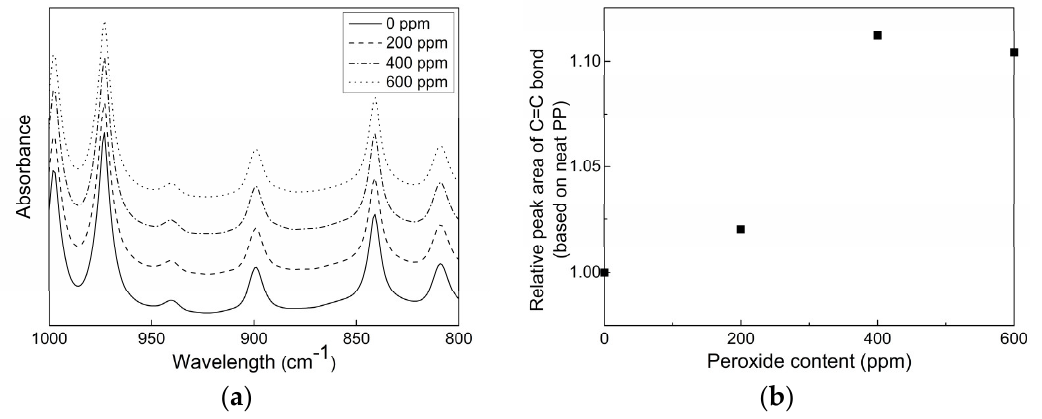
Figure 4. ( a ) FT-IR spectra for CR-PPs with different peroxide contents in the range of 1000 to 800 cm −1 wavenumber. ( b ) Peak area of C = C bonds for CR-PPs relative to that of neat PP.